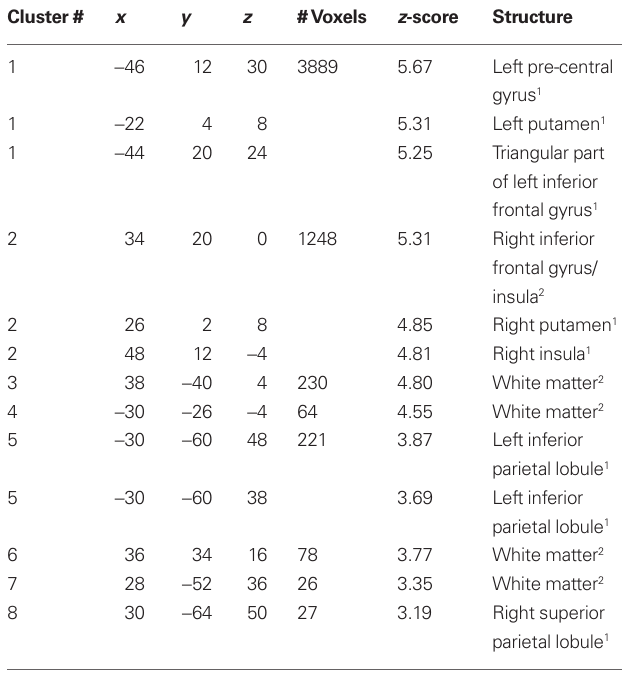
1 Overview of all large clusters of activity, showing the total number of activated voxels and coordinates of local maxima at a threshold of 0.05 and voxel extent of 20, whole-brain FDR corrected. Of those clusters that could be labeled with the automated anatomical atlas (AAL) structure names are shown as identified by the AAL. 2 Structures in clusters that could not be labeled with the AAL were identified on visual